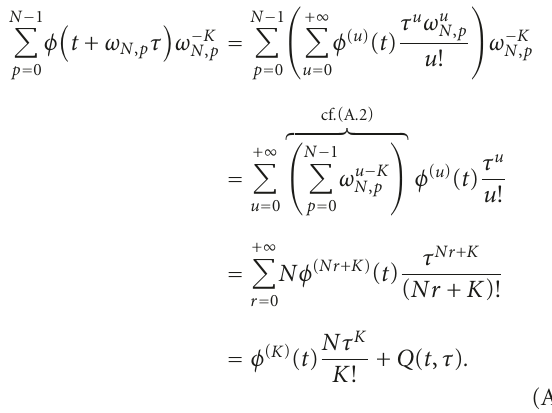
Figure 18: (a) Signal s noised at SNR = 10db; (b) IFL obtained by GCD; (c) associated detection curve.